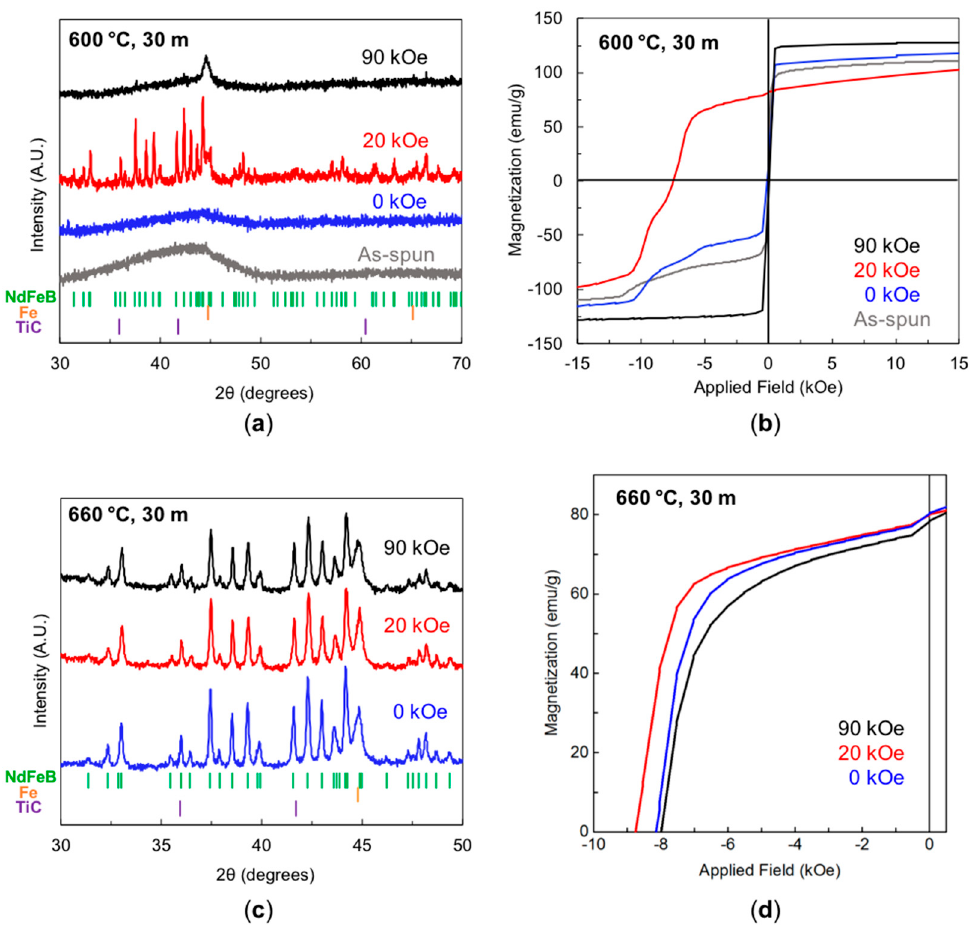
Figure 2. Characterization of Nd 2 Fe 14 B ribbons after annealing for 30 min at 600 °C showing ( a ) XRD (Cu K α 1 radiation, λ = 1.5406 Å) spectra and ( b ) isothermal magnetization curves (SQUID) measured at room temperature upon decreasing the field, and after annealing for 30 min at 660 °C showing ( c ) XRD and ( d ) isothermal magnetization curves.